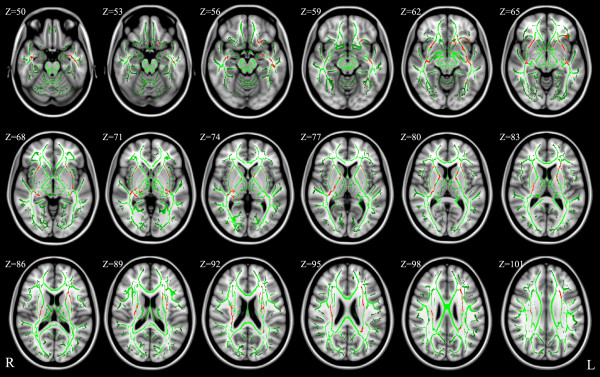
Results from TBSS analysis showing the regions of significant FA reduction in adolescent GAD patients compared with healthy controls, (p < 0.05, TFCE-corrected). Voxels are overlaid on the white matter skeleton (green). The regions of significant FA reduction are shown in red. The background images are MNI152 template. MNI, Montreal Neurological Institute; L, left; R, right.